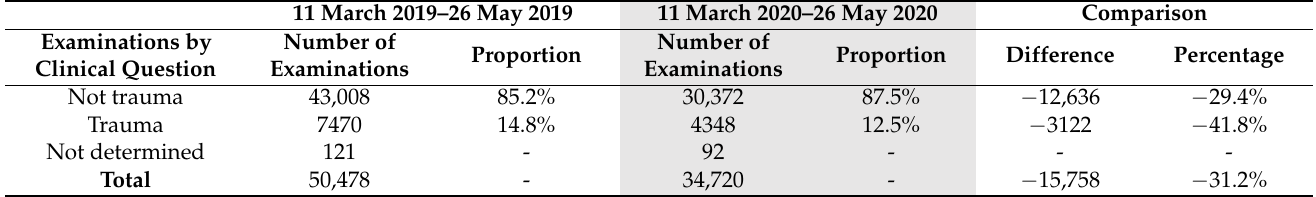
Table 5. Diagnostic examinations performed within the ordinary activity (11 March 2019–26 May of our institution; data on examinations are sorted based on the clinical question for which their